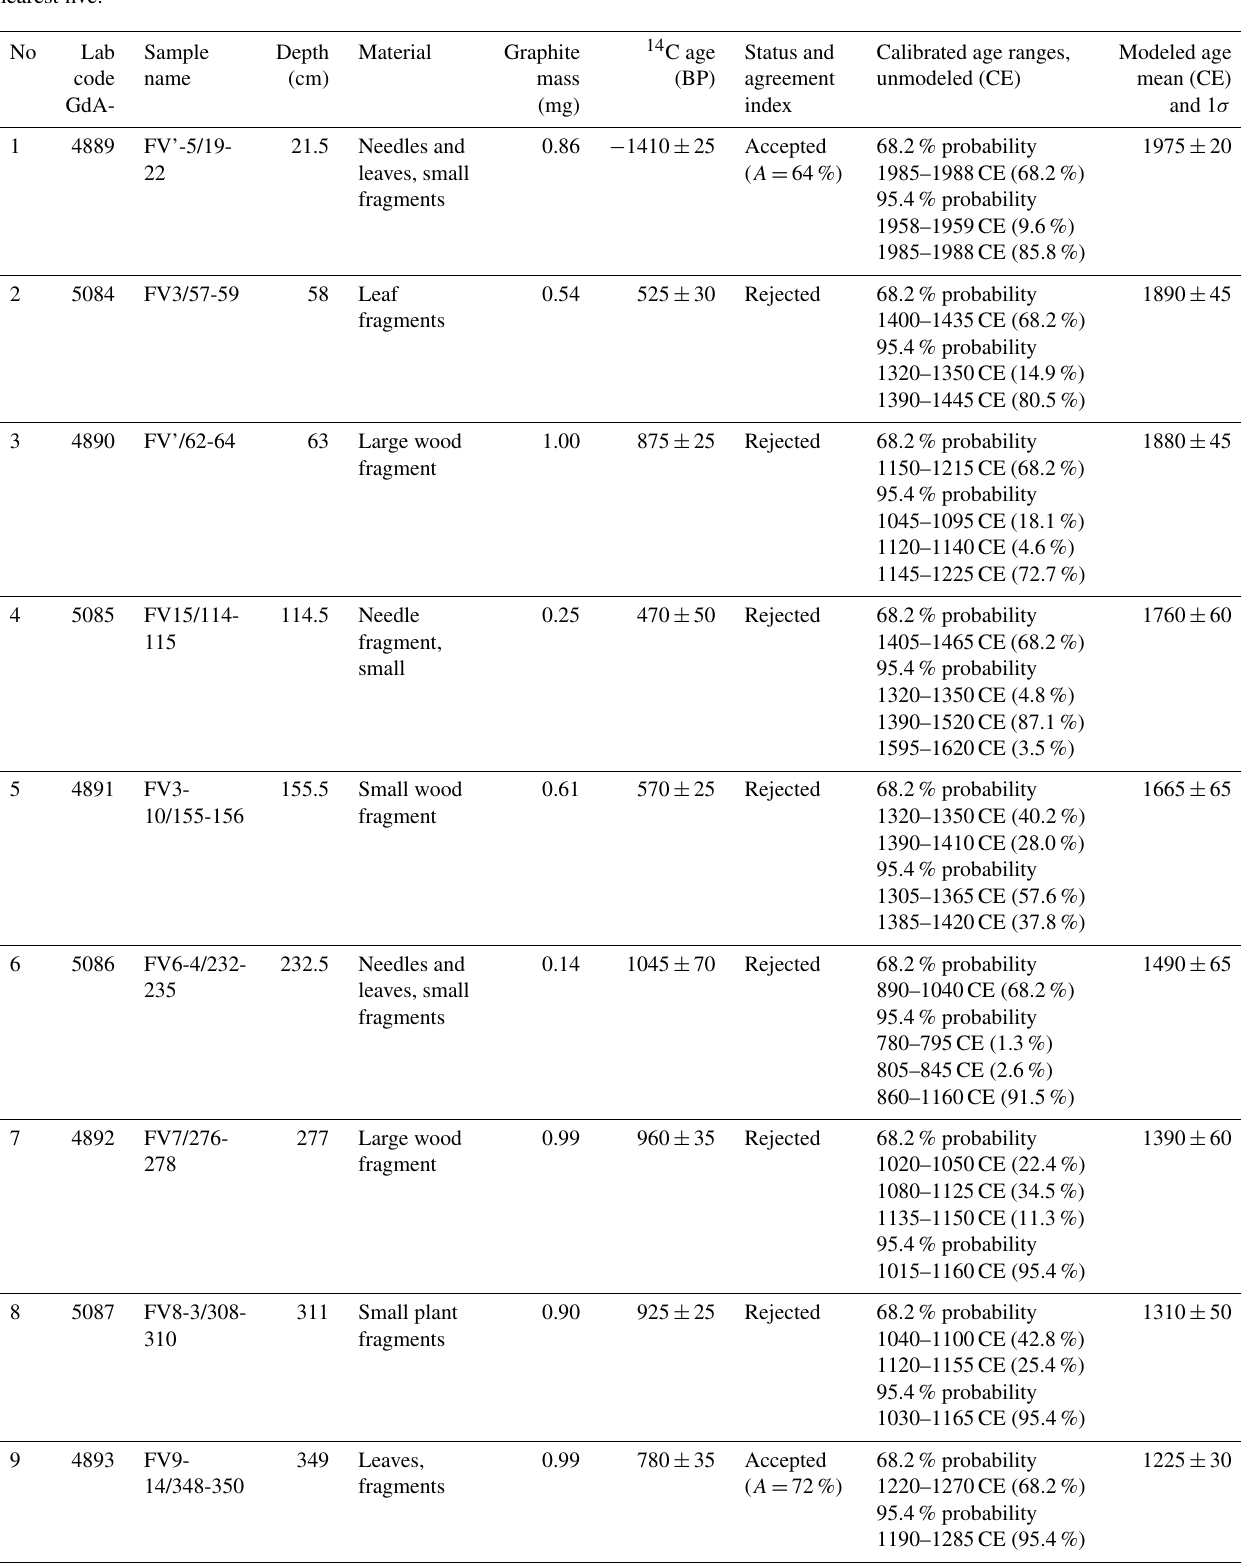
Table 1. Radiocarbon data from the Focul Viu Ice Cave. Agreement indices for individual samples based on the P_Sequence algorithm (Bronk Ramsey, 2008) are provided for accepted dates. Modeled ages for all dated depths are given as mean and σ values, rounded to the nearest